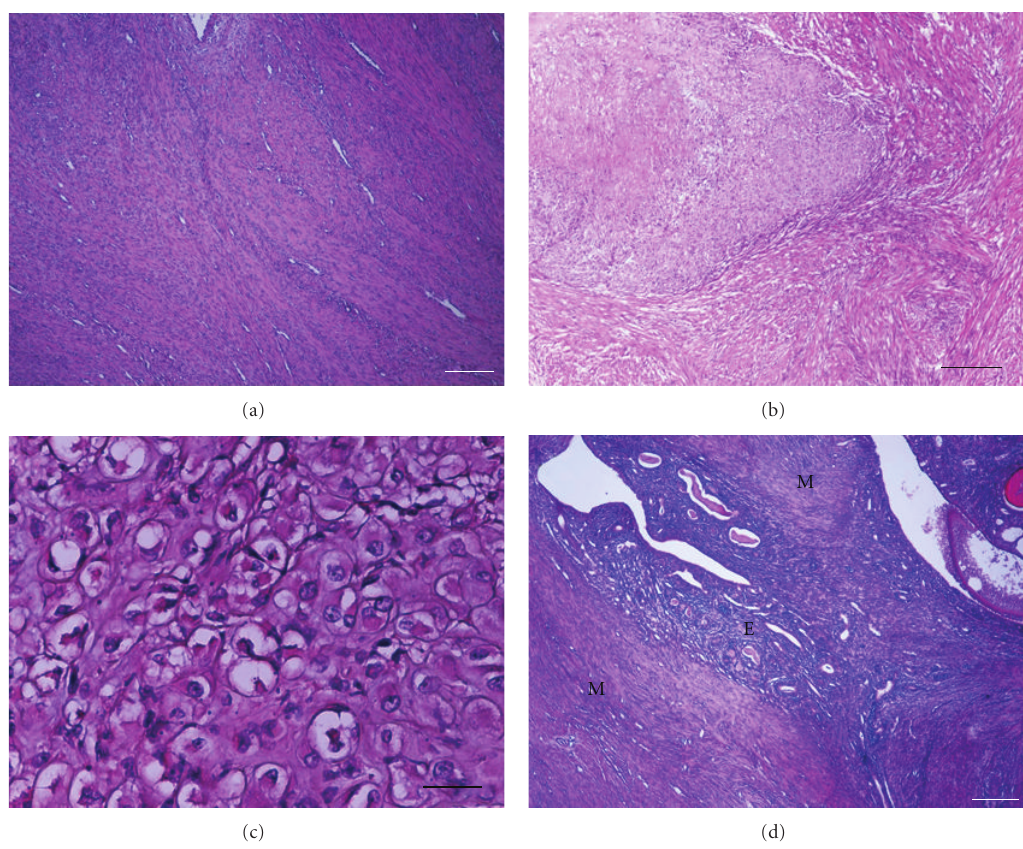
Figure 2: Histological presentation of the lesions described. Leiomyoma (a, b, c) containing epithelial tissue (b, c). (a) The mesenchymal component of the tumour was composed of well-di ff erentiated smooth muscle cells arranged in streams or interlacing bundles. H&E, bar = 200 µ m. b and c Epithelial foci. (b) H&E, bar = 1000 µ m. (c) H&E, bar = 62.5 µ m. (d) Mild adenomyosis and mild cystic endometrial hyperplasia. Hyperplastic endometrial glands (E), some cystic, extending between the muscle bundles of the myometrium (M). H&E, bar = 200 µ